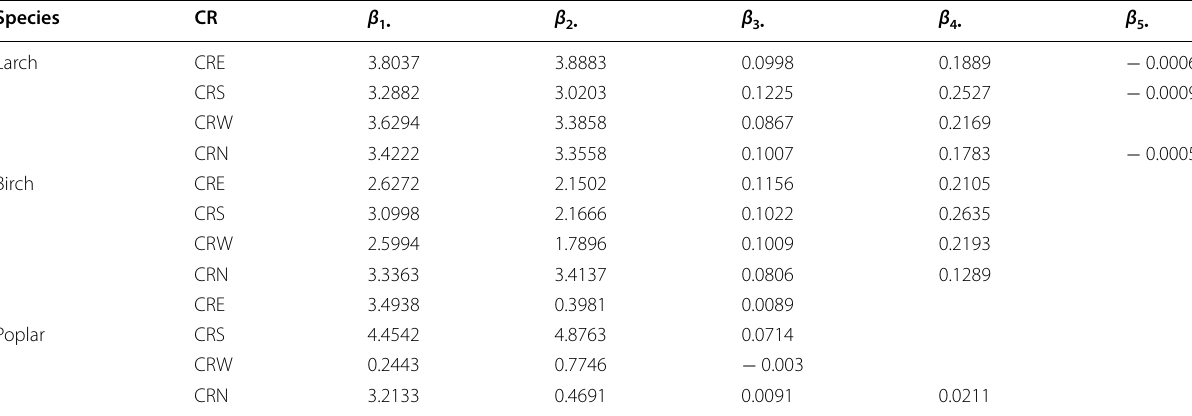
Note : All the fixed parameters are statistically significant at P